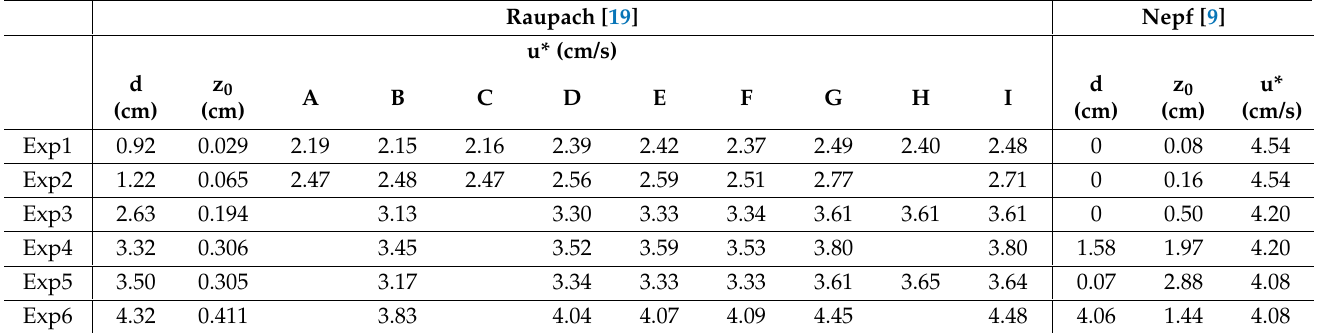
Nepf [9], in a review of relevant previous work, considered the application of Equation